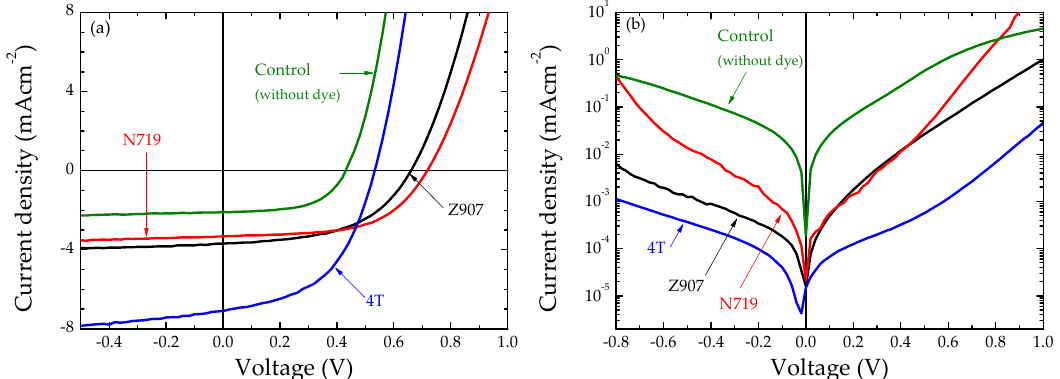
Figure 4. ( a ) J-V characteristics of the fabricated TiO 2 / P3HT and dye-modified TiO 2 / P3HT solar cells under simulated irradiation of 100 mW cm − 2 (1 sun) with Air Mass 1.5 filter and ( b ) semi-log J-V plot of the solar cells in dark. The complete structure of control device is ITO / TiO 2 / P3HT / Au, and the dye modified cells have the structure ITO / TiO 2 / dye / P3HT / Au. Here, dyes Z907, N719, and 4T were used as the interface